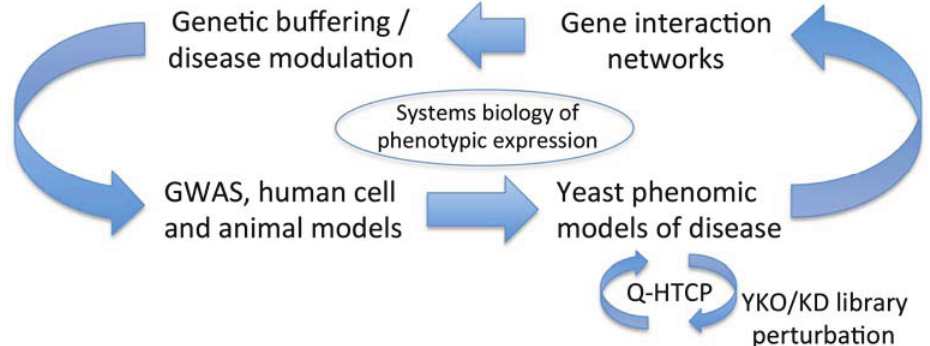
Figure 5. Yeast phenomic models can serve to discover gene interaction networks underlying expression of disease phenotypes. Disease-buffering gene interaction networks are derived experimentally by disease-relevant perturbation of the yeast gene knockout/knockdown mutant library followed by measurement of gene interaction with Q-HTCP. The resulting gene networks are queried for evolutionary conservation to generate hypotheses regarding their relevance to human phenotypes. Hypotheses can be tested in translational models, leading to model validation or refinement, with iterative yeast phenomic analysis for further